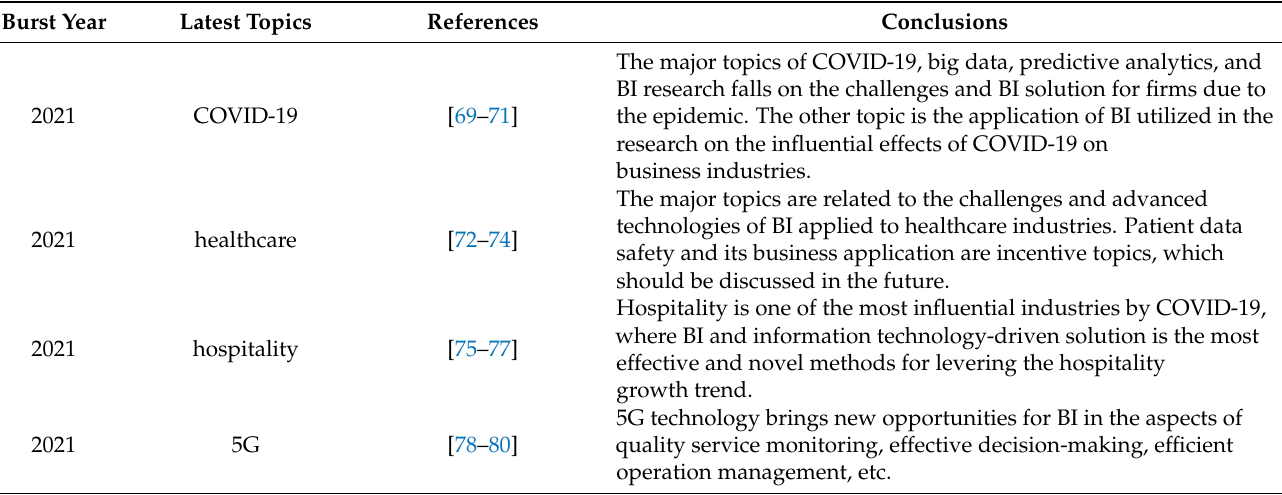
Table 11. The latest topics burst in